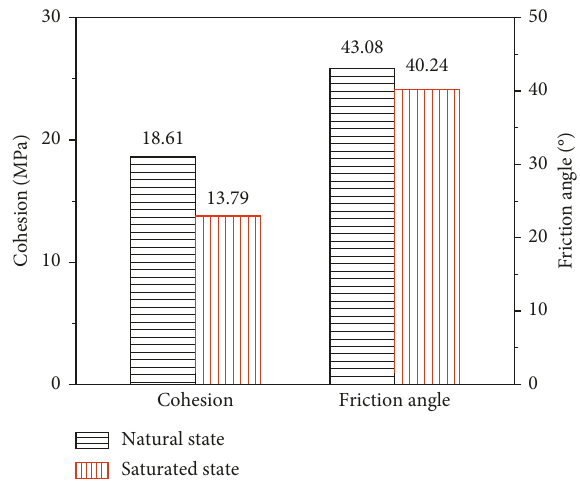
Figure 4: Cohesion and friction angle of argillaceous limestone in the natural and saturated states,